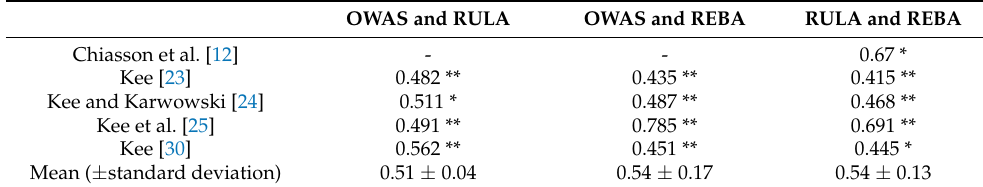
Table 4. Correlation coefficients between